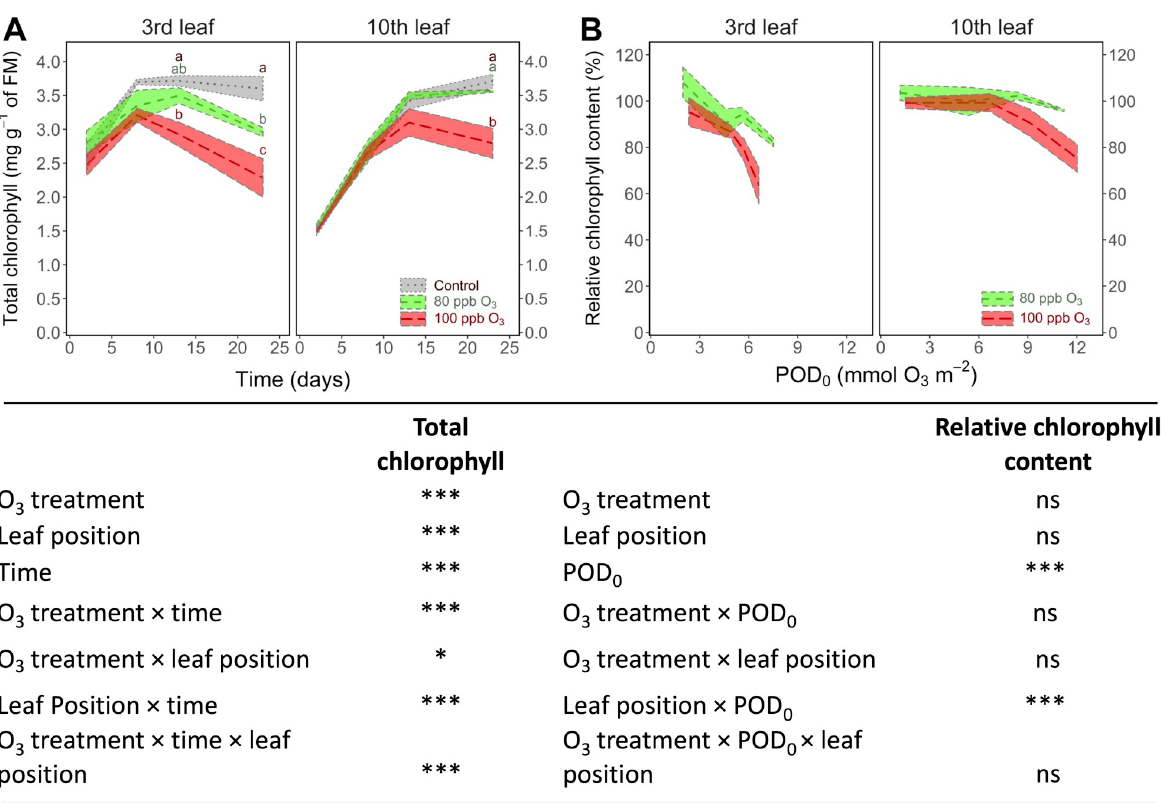
Fig 2. Dynamics of changes in the total chlorophyll concentration within leaves of hybrid poplar ( Populus tremula x alba ) as a function of assessment time (A; mg g -1 of fresh matter), POD 0 (B; percentage of values in the CF treatment). O 3 treatment (dotted line: CF, dashed line: CF +80 ppb O 3 , long dash line: CF +100 ppb O 3 ), leaf position, and their interactions (model: lmer(variable) ~ O 3 treatment � leaf position � time or POD 0 + (1 | tree/chamber)); ��� P � 0.001, � P � 0.05, ns not significantly different). Values represent means ± SE (n = 4). Different letters indicate significant differences between treatments on a given assessment date (post-hoc Tukey’s HSD, P �